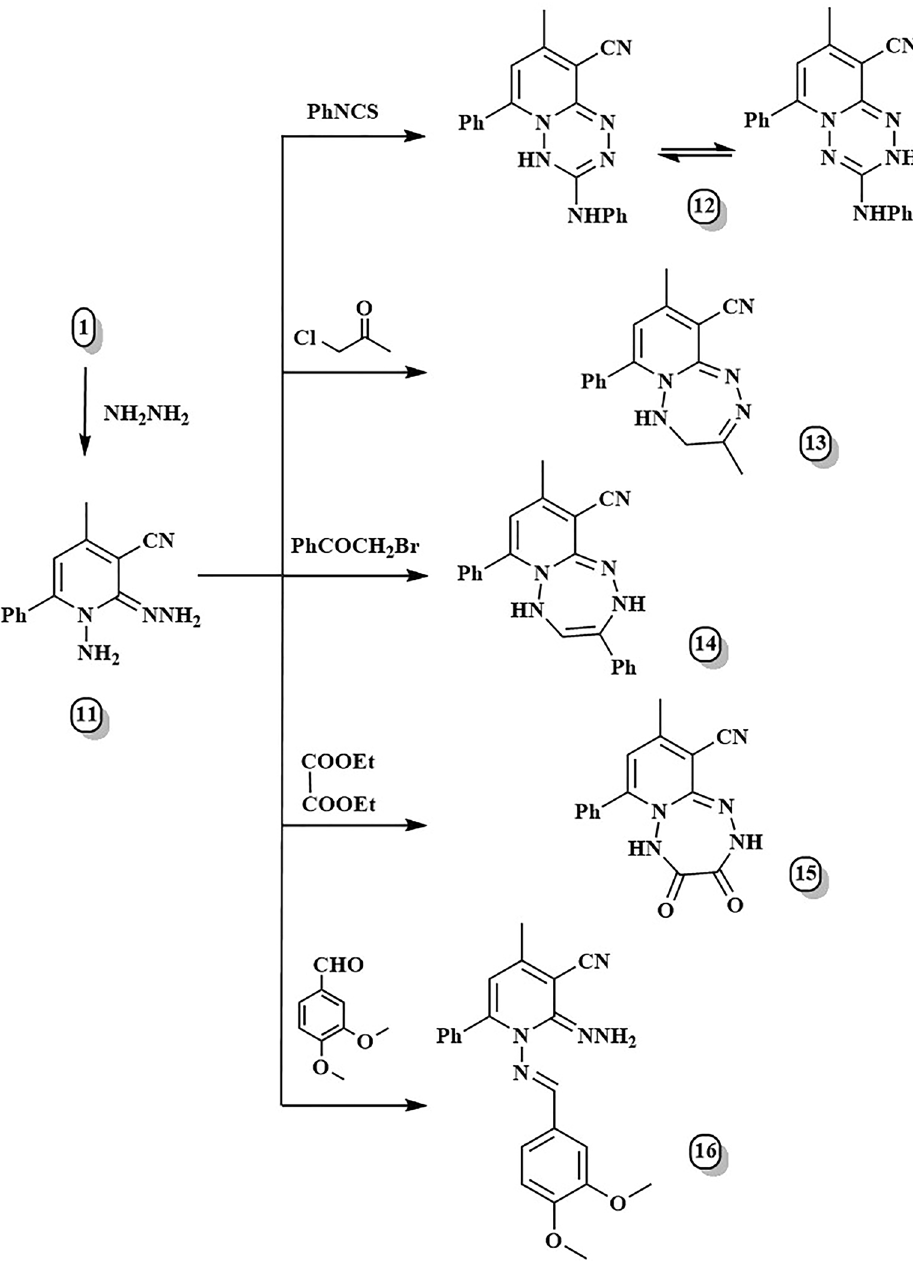
Figure 3. Synthesis of compounds 11 – 16